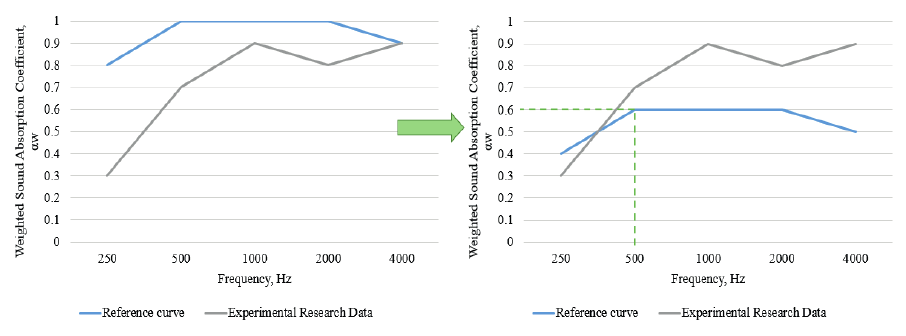
Fig. 5. Weighted sound absorption coefficient determination